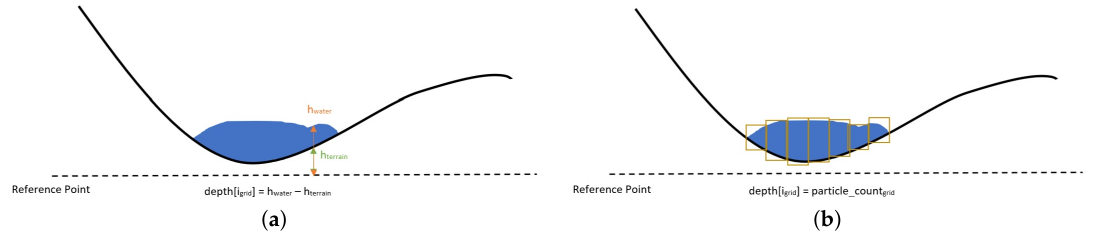
Figure 4. Computation of depth using ( a ) relative height differences, ( b ) fluid volume through number of particles per